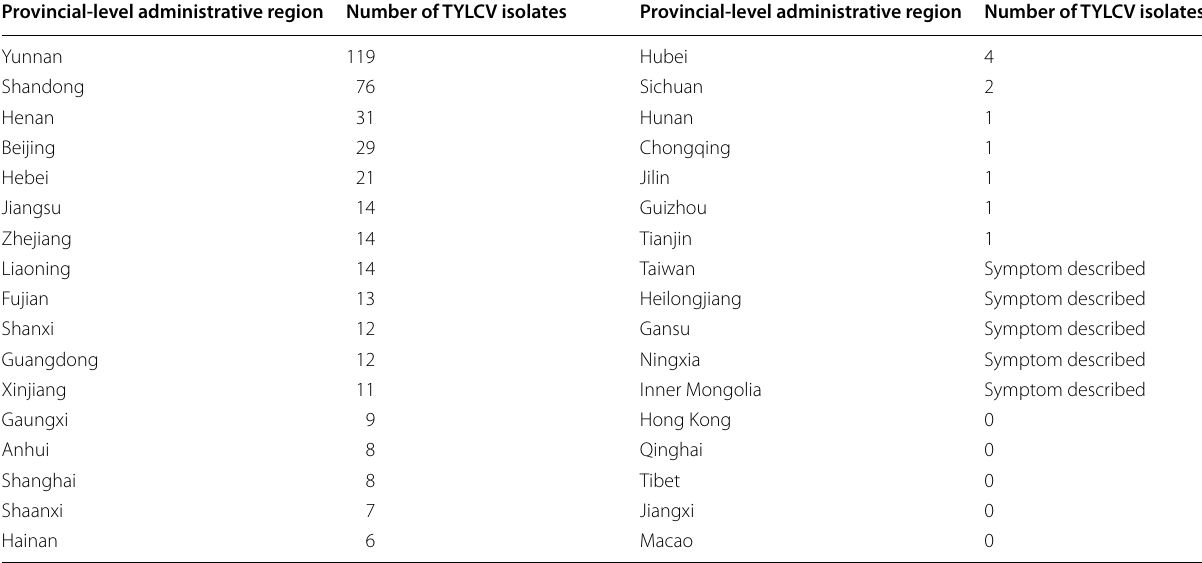
Table 1 Geographical distribution of TYLCV isolates in China Provincial-level administrative region Number of TYLCV